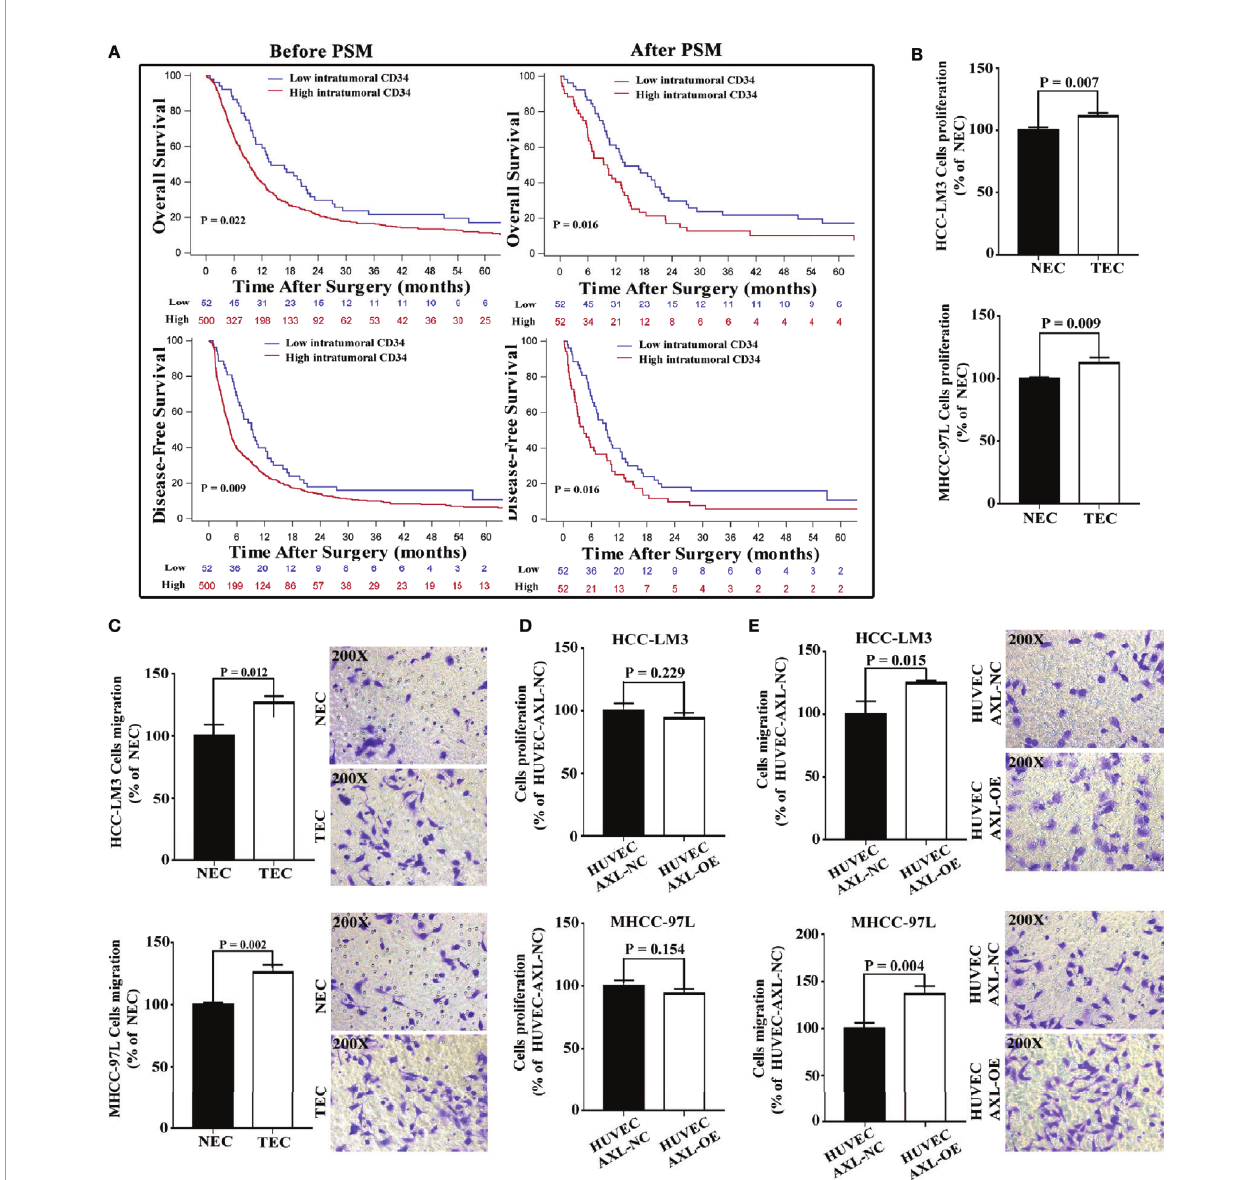
FIGURE 4 | Overexpression of AXL in HUVECs promotes migration but not proliferation of HCC cells. (A) Before PSM, high intratumoral CD34 expression was shown to be associated with poor OS and DFS in HCC patients with PVTT (PVTT: p = 0.022 and p = 0.009). After PSM, high intratumoral CD34 expression was shown to be associated with poor OS and DFS in HCC patients with PVTT (PVTT: p = 0.016 and p = 0.016). (B) The culture medium of TECs promoted the proliferation of HCC-LM3 cells and MHCC-97L cells compared with the culture medium of NECs. (C) The culture medium of TECs promoted the migration of HCC-LM3 cells and MHCC-97L cells compared with the culture medium of NECs. (D) The culture medium of HUVECs overexpressing AXL could not promote the proliferation of HCC-LM3 cells and MHCC-97L cells compared with that of normal HUVECs. (E) The culture medium of HUVECs overexpressing AXL promoted the migration of HCC-LM3 cells and MHCC-97L cells compared with that of normal